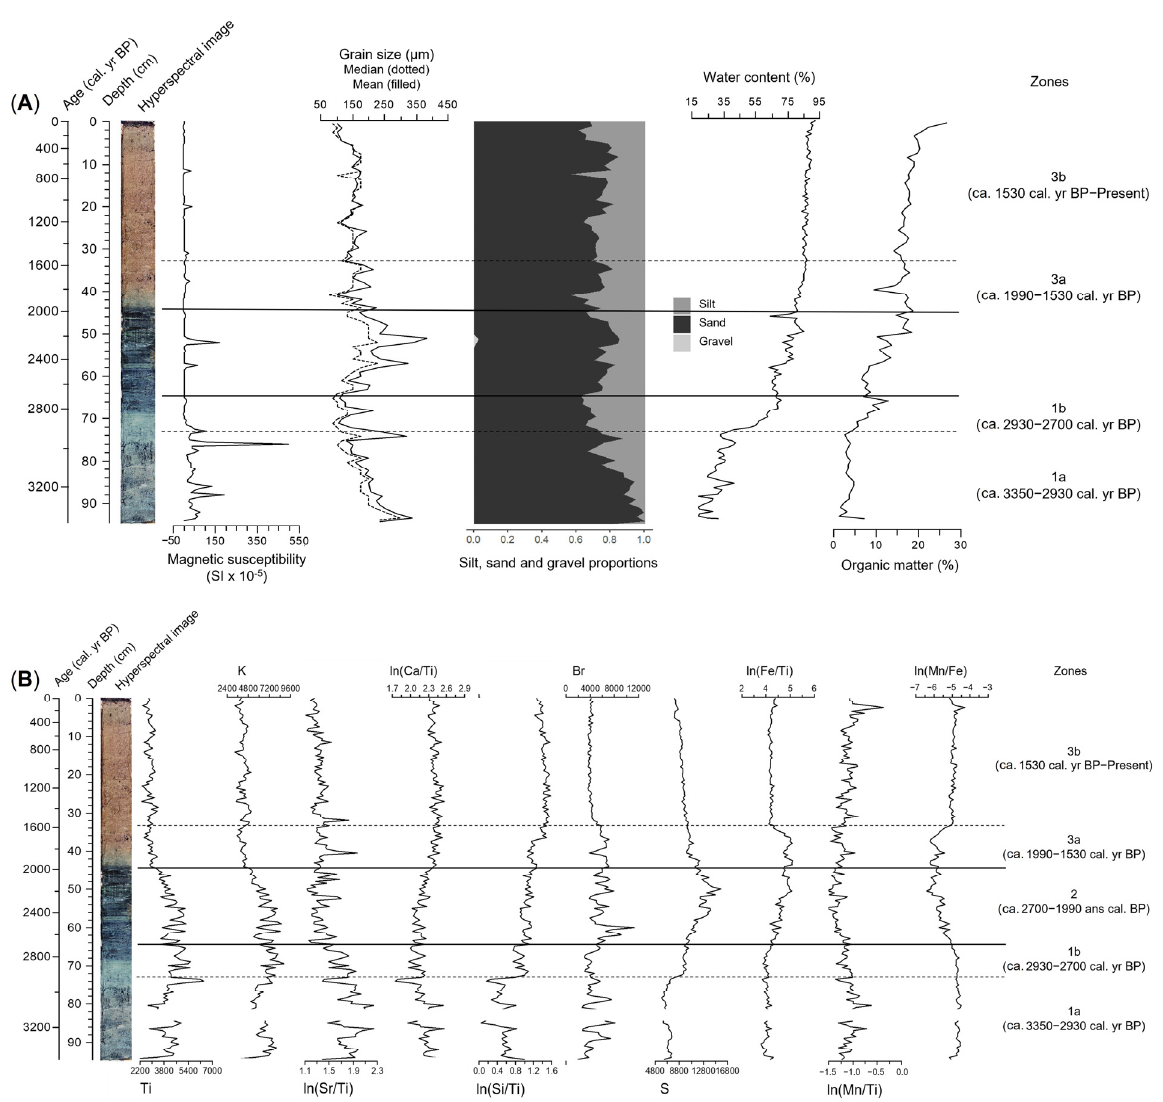
Figure 6. ( A ) Litho-sedimentological profiles of the Evilik Lake core and significant stratigraphic zones (CONISS); ( B ) geochemical profiles ( µ -XRF) of the Evilik Lake core and stratigraphic zones (CONISS). The three main zones correspond, respectively, to the glacio-marine, brackish, and lacus- trine phases.